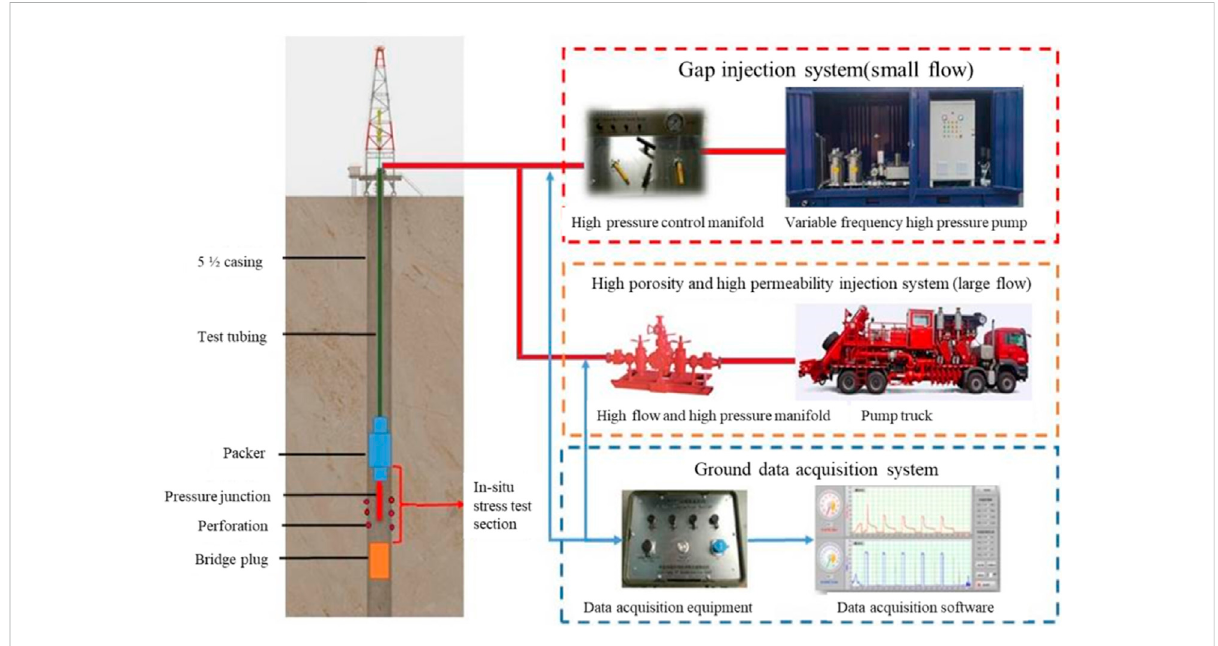
FIGURE 1 Schematic diagram of the hydraulic fracturing stress measurement